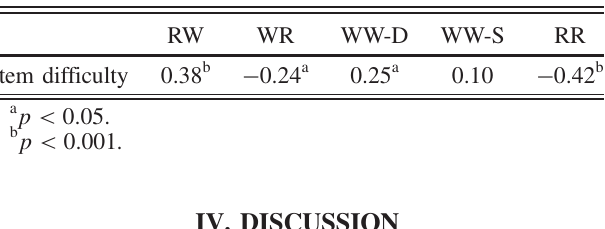
TABLE III. Correlation between the difficulty of each item (as estimated using a 2PL IRT model) and the fraction of students who, for that item, have a different wrong answer in each round (WW-D), switch from the right answer to a wrong answer (RW), switch from a wrong answer to the right answer (WR), have the same wrong answer in both rounds, and have the right answer in both